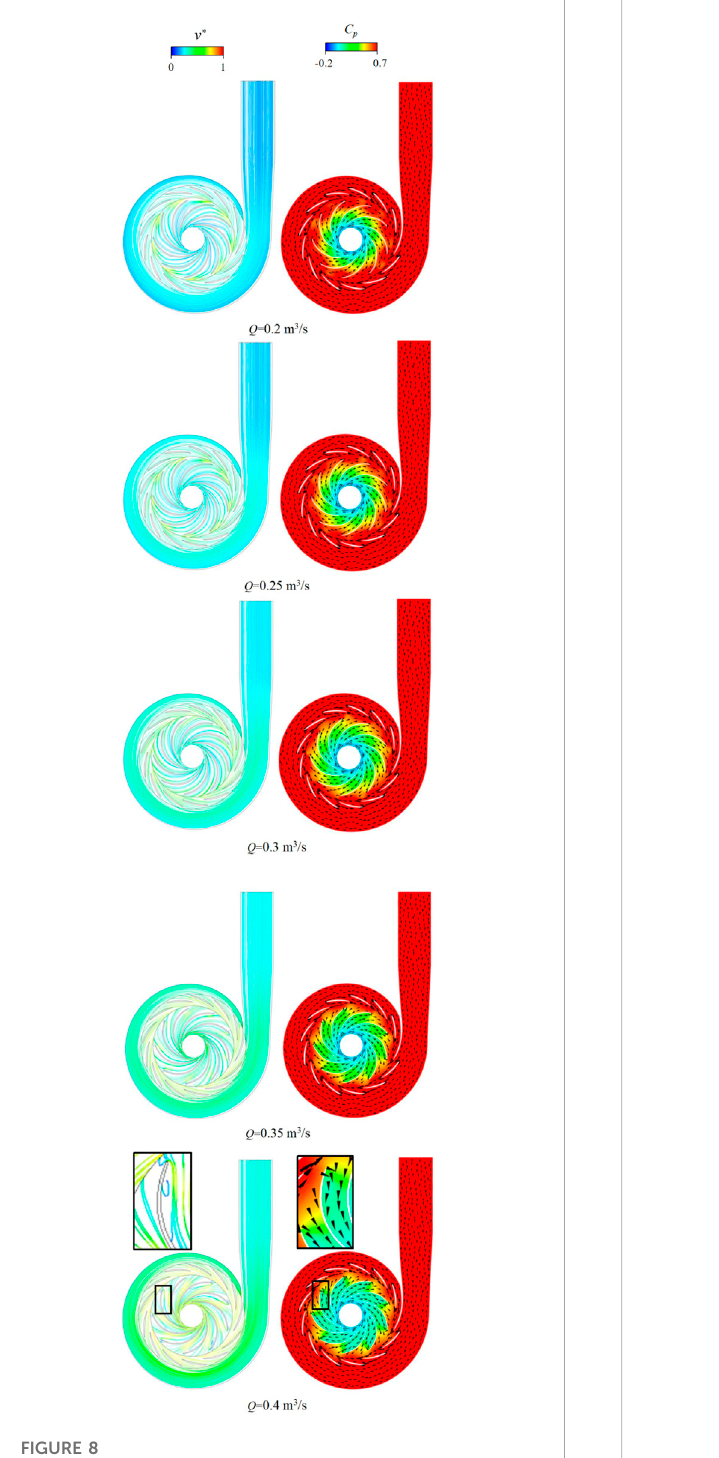
FIGURE 8 Streamline and pressure velocity distribution of turbine mode. FIGURE 9